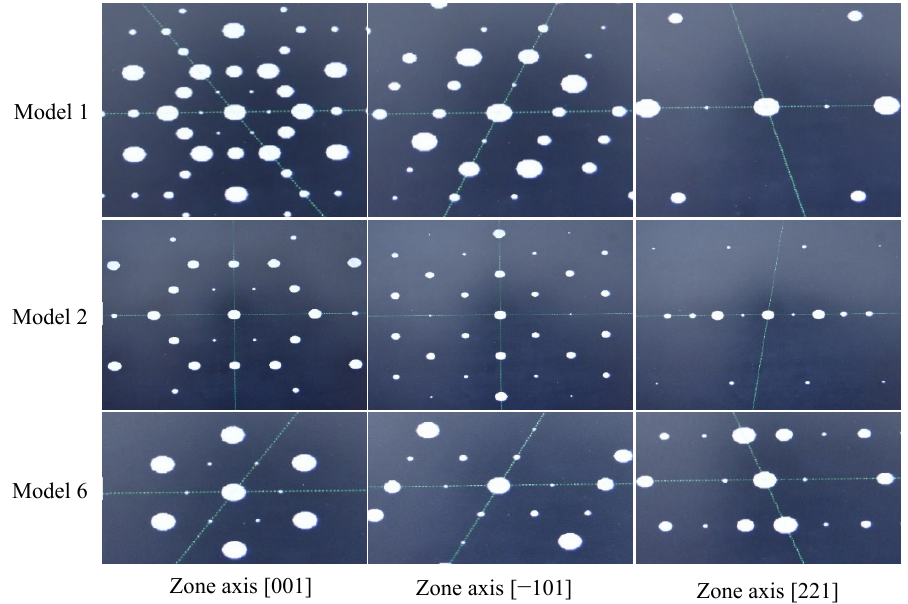
Figure 5. Density functional theory (DFT) simulated SAD of Models 1, 2, and 6 along the [001], [ − 101], and [221].